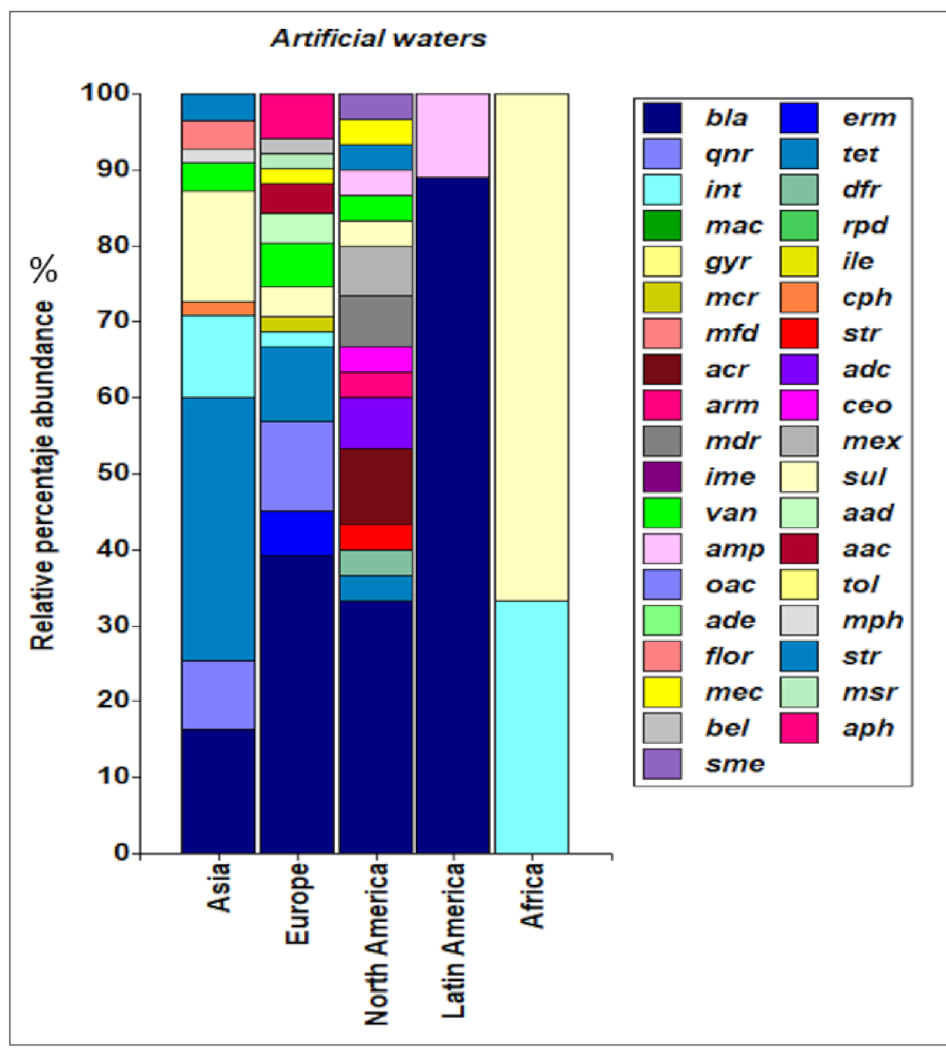
Figure 6. Types of genes reported in artificial waters according to geographic distribution. bla (gene with resistance to betalactamase), qnr (gene with resistance to quinolones), int (integron), mac (gene with resistance to macrolides), gyr (gene encoding a subunit of DNA gyrase), mcr (gene with resis- tance to colistin), mfd (Mutation-Frequency-Decline: onfers resistance to the host nitrogen immune response), acr ( gene that codes for acrosin), arm (Aminoglycoside resistance methyltransferase), mdr (The multiple drug resistance gene mdr encodes the so-called P-Glycoprotein), ime (Intron-mediated enhancement), van ( gene with resistance to vancomicine), amp (gene with resistance to ampiciline), oac (gene with resistance to clarithromycin), ade (gene with resistance to tetracycline and glycylcycline), floR (gene with resistance to fluoroquinlones), mec (gene with resistance to methicillin), bel (type of extended spectrum beta-lactamase), sme ( gene with resistance to carbapenems), erm (gene with resistance to erythromycin), tet (gene with resistance to tetracycline), dfr (gene with resistance to trimethoprim), rpd (gene with resistance to macrolides), ile (gene with resistance to quinolones), cph (gene with resistance to imipenem), str (gene with resistance to streptomycin), adc (is a type of A mpC , with resistance to ampicillin), ceo (gene with resistance to cefoperazone), mex (gene with resistance to tetracycline), sul (Sulfamethazine), aad (gene with resistance to aminoglycosides), aac (gene capable of acetylating fluoroquinolones), tol (gene with resistance to doxycycline), mph ( gene with resistance to macrolides), str (gene with resistance to streptomycin), msr (gene with resistance to macrolides, lincosamides and streptogramins), aph (gene with resistance to